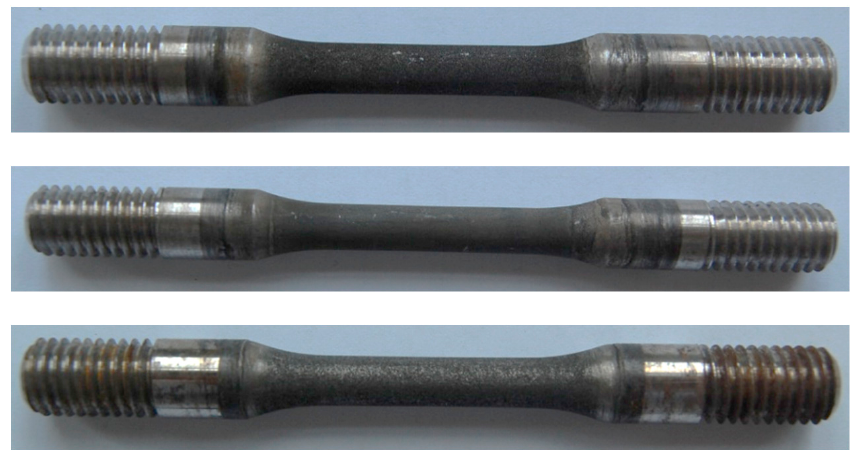
Figure 8. SSC evaluation test specimens of steel C.